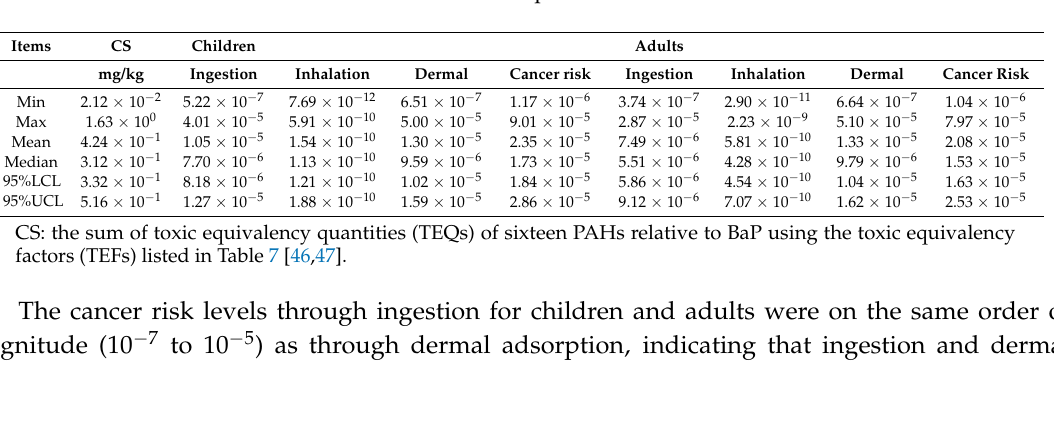
Table 8. Health risk of human exposure to PAHs in urban